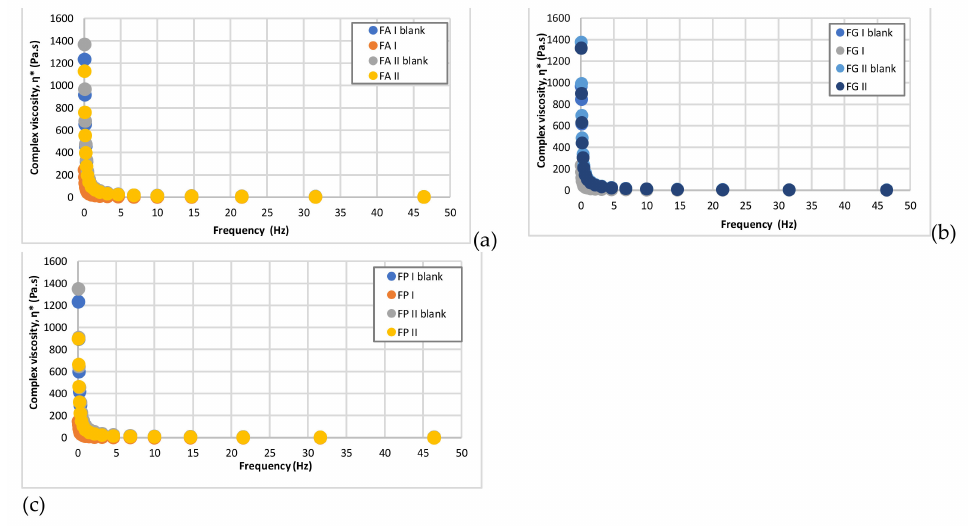
Figure 7. Variation of complex viscosity η * as a function of frequency for the studied hydrogels: ( a ) FAI blank, FAI, FAII blank, FAII; ( b ) FGI blank, FGI, FGII blank, FGII; ( c ) FPI blank, FPI, FPII blank, FPII.